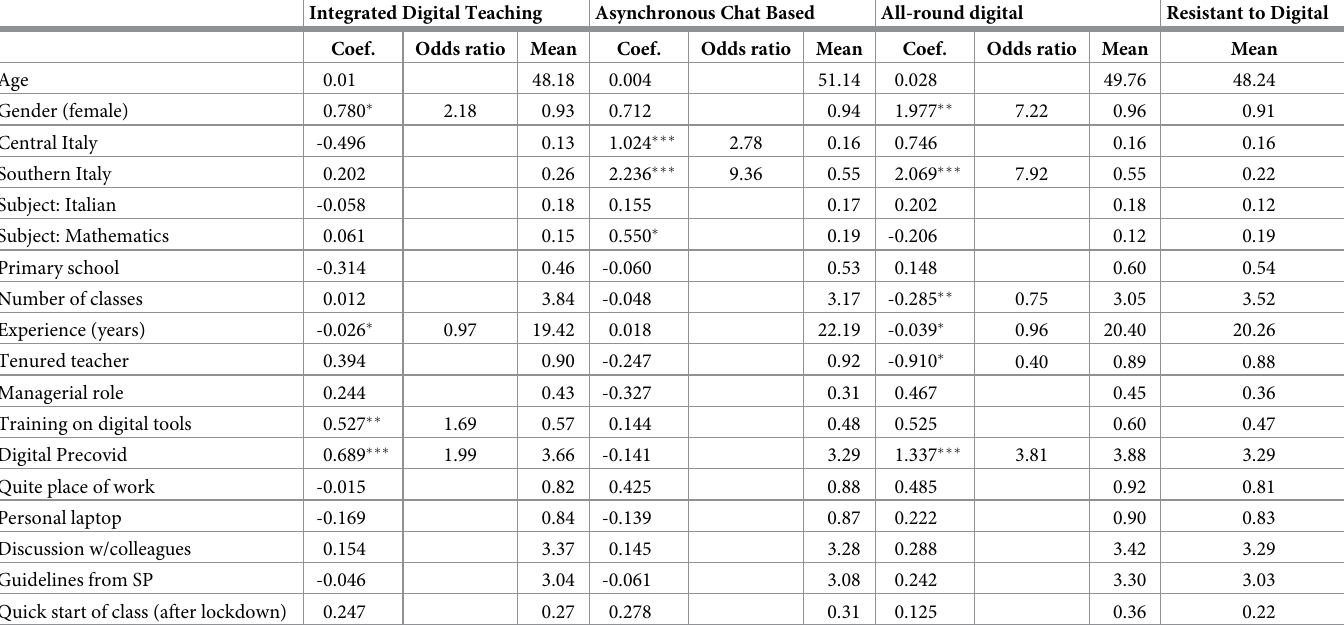
Table 3. Step 2—Characterising the latent